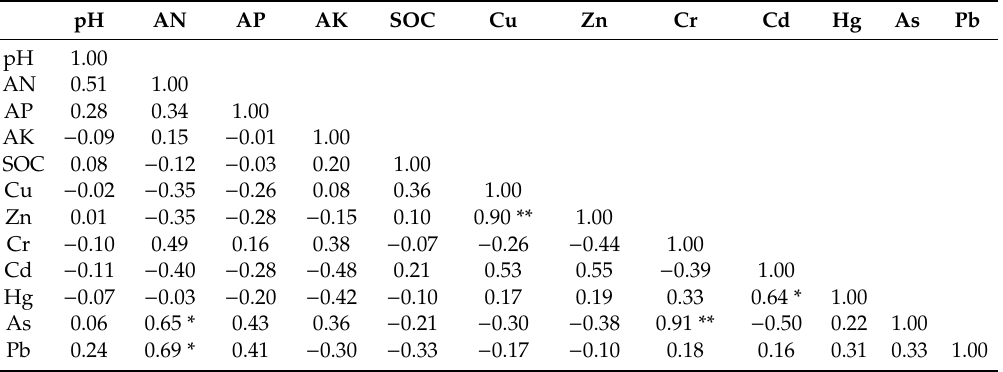
Table 2. Pearson’s correlation matrix for heavy metals and other physicochemical